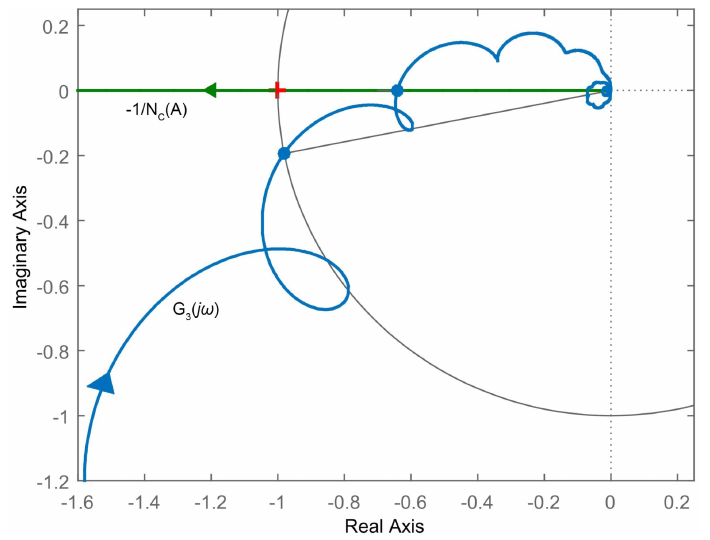
Figure 7. Limit cycle